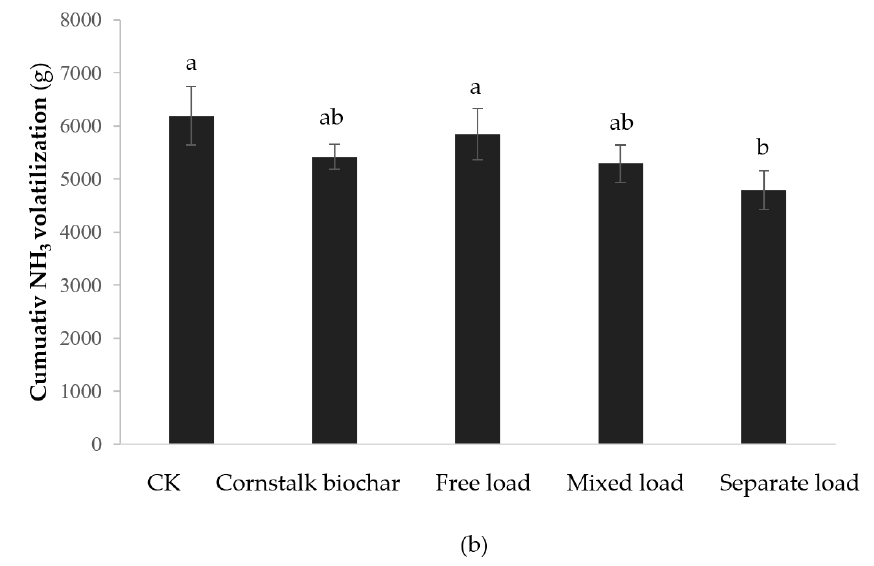
Figure 1. Changes of NH 3 emissions in different load methods during composting; Note: ( a ) NH 3 emission during the composting, ( b ) total NH 3 emission (CK: as the control). Error bars represent the standard deviation ( n = 3); TS: total solid; a–b Columns reporting different letters are significantly different ( p < 0.05).